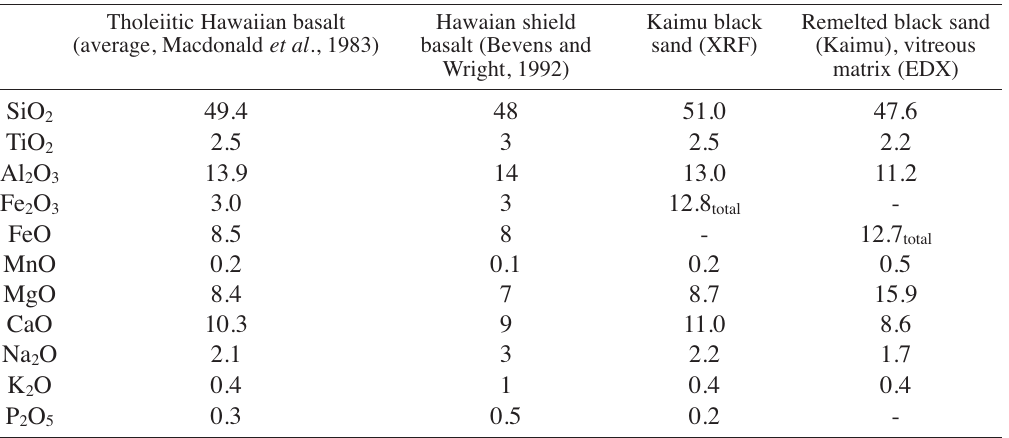
Table I. Chemical composition of Hawaiian basaltic lava. Tholeiitic Hawaiian